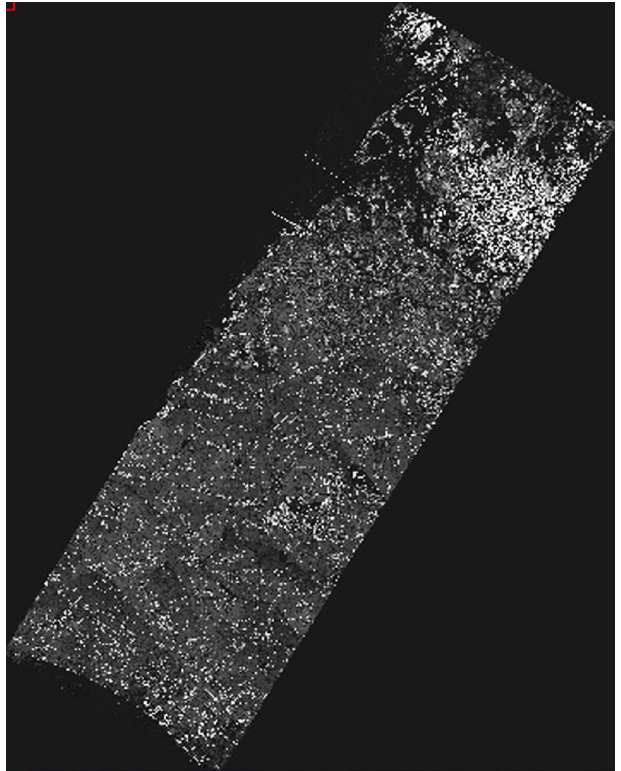
Figure 2. Canopy height model (CHM) data of the Heihe River Basin based on the airborne light detection and ranging (LiDAR) system.